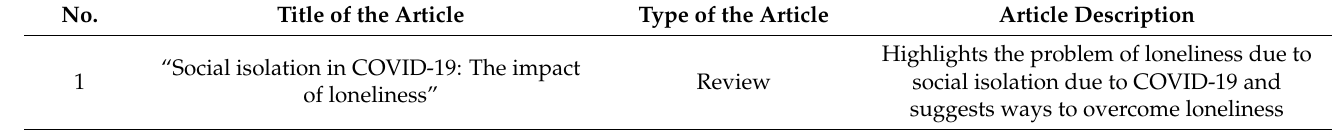
Table 2. Systematic analysis results—top 10 articles and their